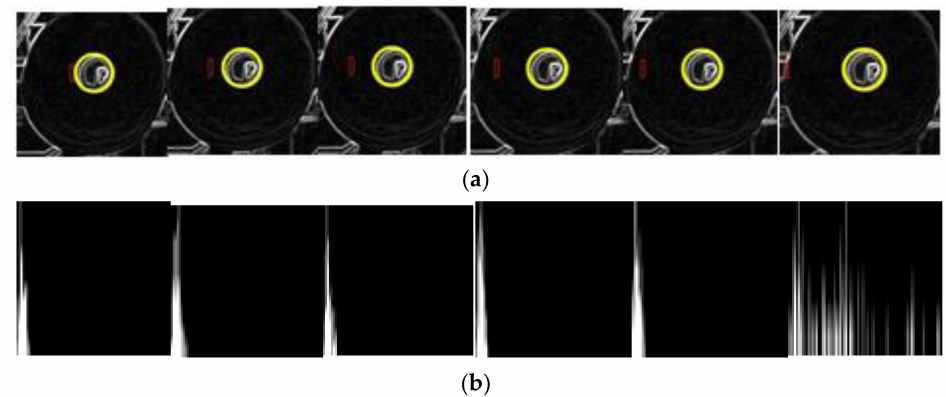
Figure 15. ( a ) The red rectangle is the area to calculate the gray value. ( b ) The gray-scale histogram of red